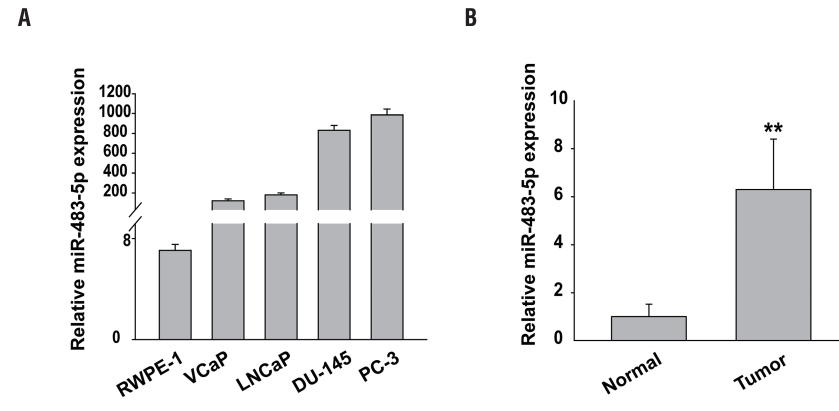
figure 1 - miR-483-5p is significantly upregulated in prostate cancer cell lines and tissues. A, histograms of the average relative expression of miR-483-5p in a normal prostate epithelial cell line and prostate cancer cell lines as shown. B, relative ratios of miR-483-5p expression in 26 prostate cancer tissues compared with 10 normal prostate tissues.